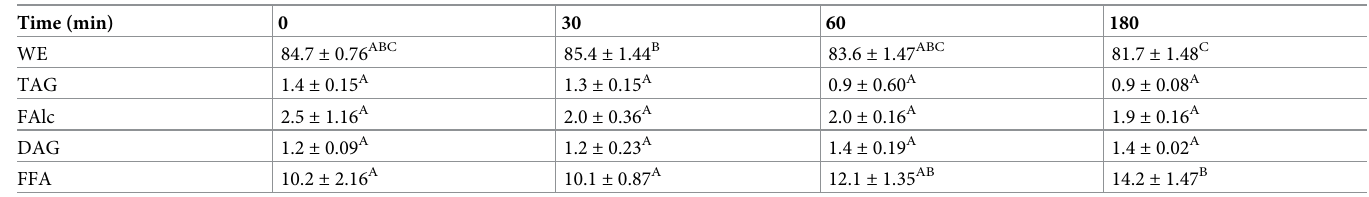
A,B,C (Results in the same row sharing superscripted letters are not significantly different (P � 0.01)). Wax esters (WE), triacylglycerol (TAG), fatty alcohols (FAlc), diacylglycerol (DAG), free fatty acids